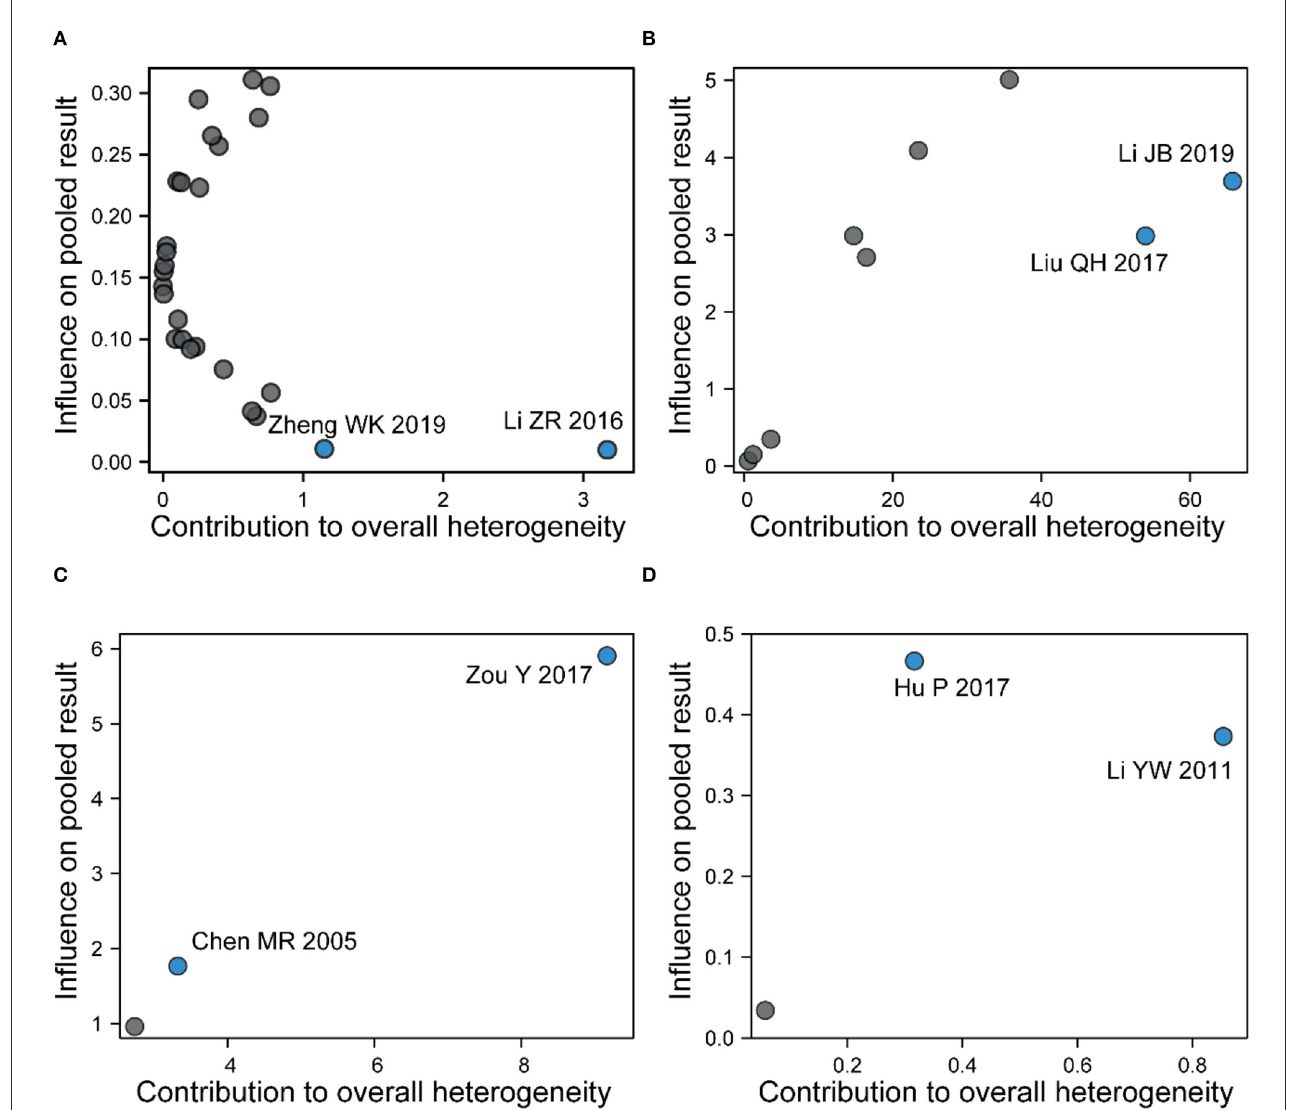
FIGURE7 A Baujat plot for (A) total effective rate, (B) pain intensity, (C) pain threshold, and (D) recurrence rate. Each circle indicates an individual study, while the circle in blue indicates the study contributing more to heterogeneity and pooled